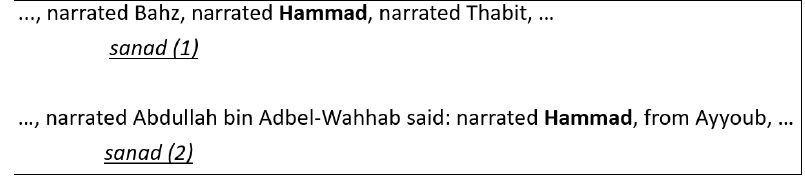
Figure 2. Illustration of ambiguous narrator name Hammad in two different sanad